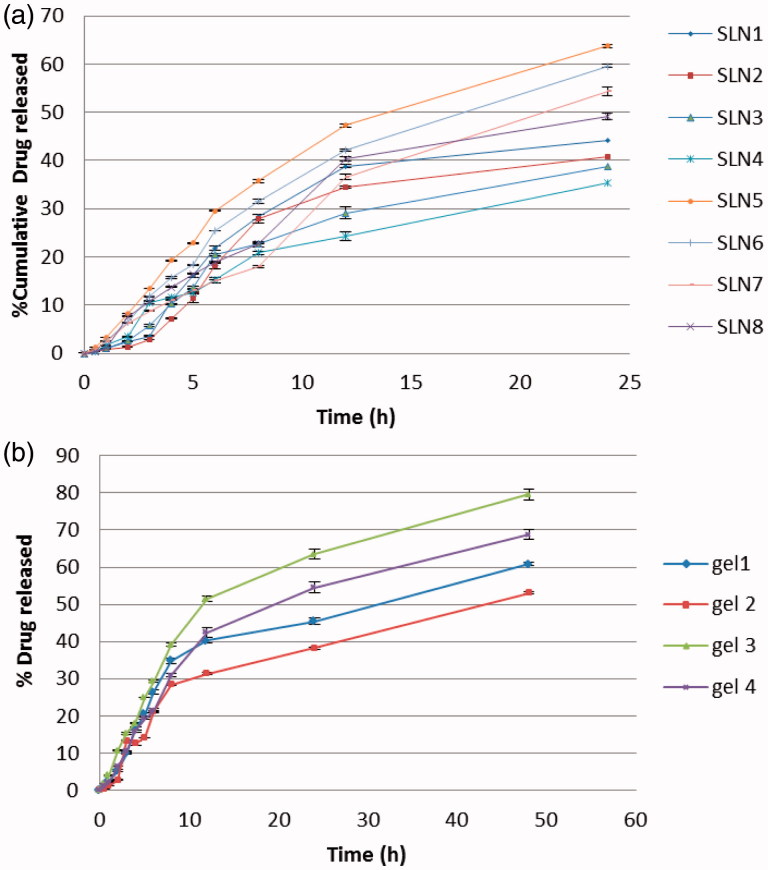

In vitro release profiles of FLZ from (a) prepared SLNs and (b) relevant SLNs gels.